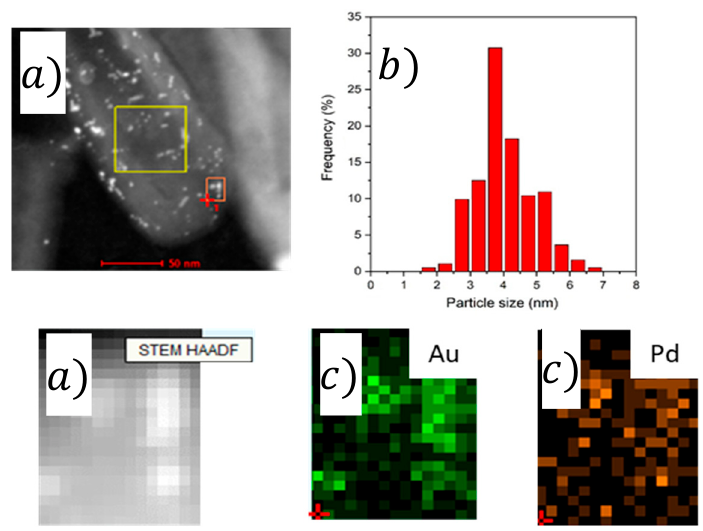
Figure 3. ( a ) TEM, ( b ) NP size distribution, and ( c ) EDX analysis of Pd 4 Au 6 catalyst.